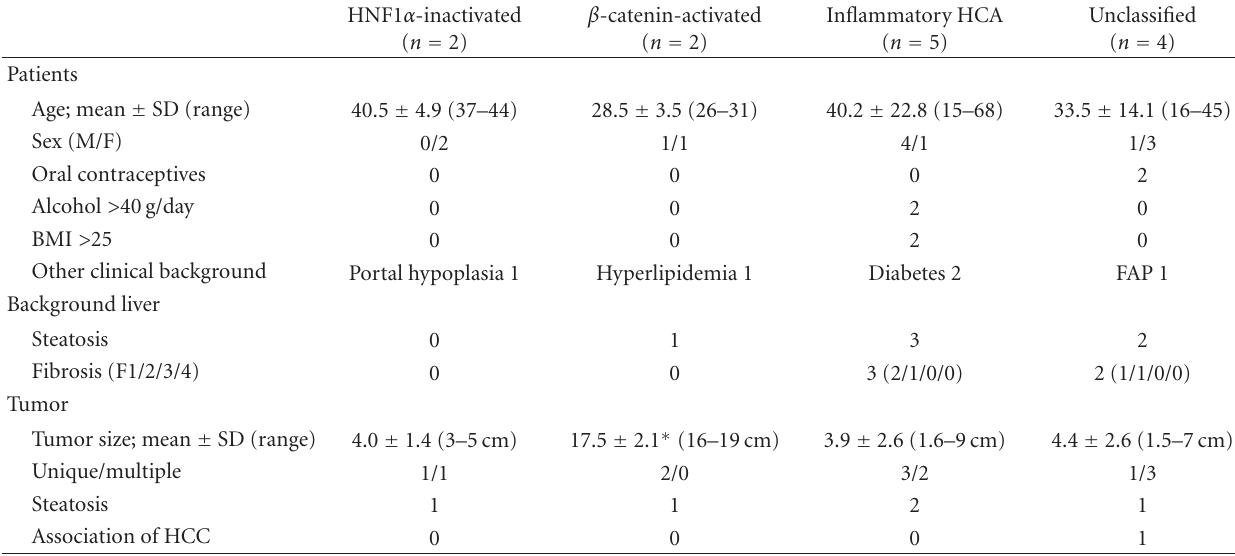
Table 1: Clinical and pathological findings of hepatocellular